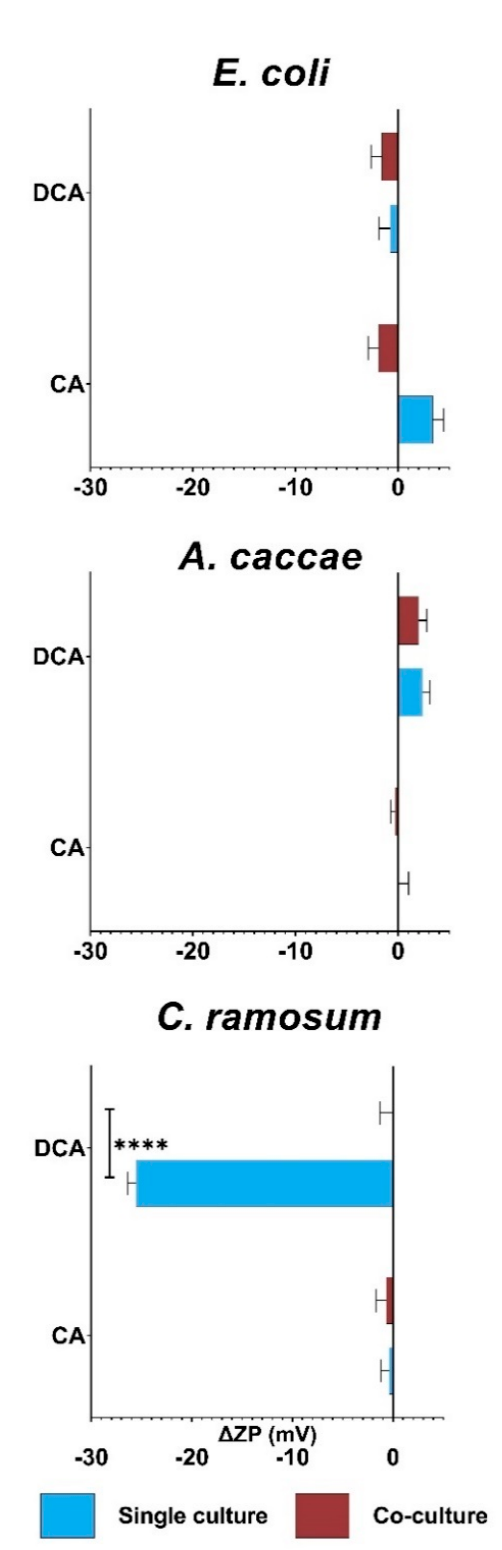
Figure 3. Relative change in zeta potential of cells in log phase exposed to bile acids. The change in ZP is compared to their respective blanks and is shown in mV. For all analyses, three replicates were analyzed and bars represent the mean value. Samples were harvested when OD 600 = 1.0 Errors bars are standard deviations. Statistical significance was determined using a Student’s t -test, * p < 0.05, **** p <